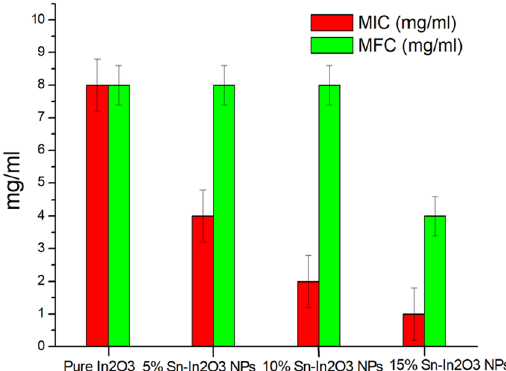
Figure 4. MIC/MFC of pure In 2 O 3 NPs and Sn doped In 2 O 3 NPs (Sn/In = 5%, 10%, 15%) against C. albicans